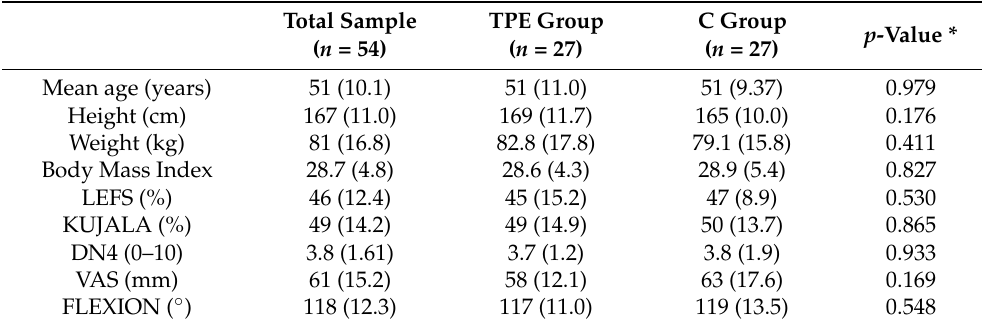
Table 2. Baseline characteristics of study